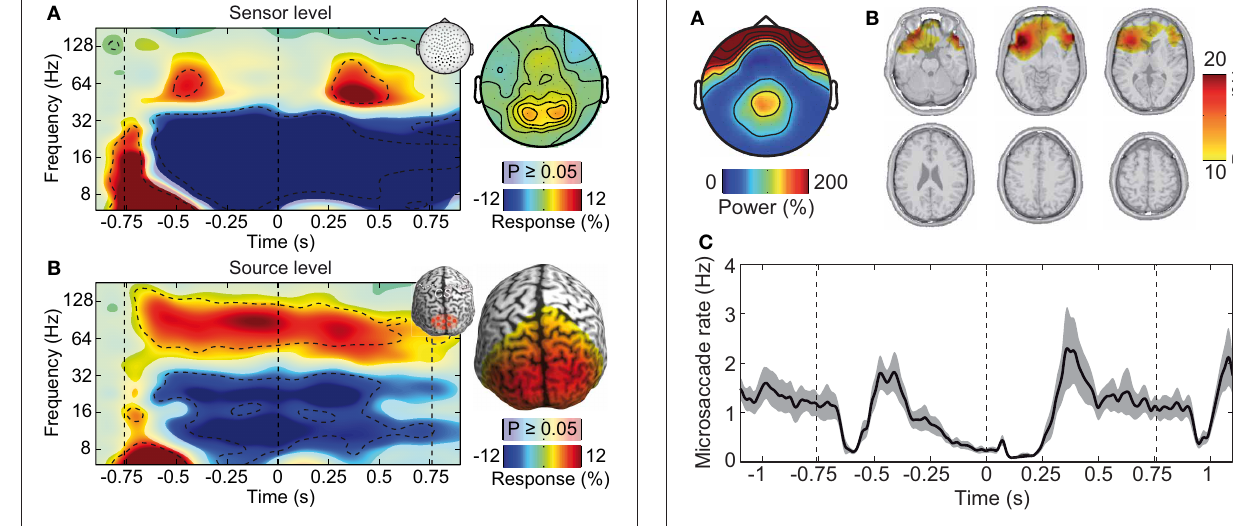
FIGURE 5 | Saccadic spike artifact that confounds the EEG signal. (A) Spatial distribution of EEG power in epochs with detected microsaccades ( ± 20ms) relative to randomly selected epochs without microsaccades. (B) Spatial localization of the signal shown in (A) using the beamforming source-analysis technique. (C) Modulation of microsaccadic spike rate during the experimental trial. The spike rate was estimated using the algorithm of Keren et al. (2010) that is based on filtering and thresholding the radial EOG signal. Gray shading indicates standard error. Immediately after stimulus onset ( − 0.76 s), microsaccade